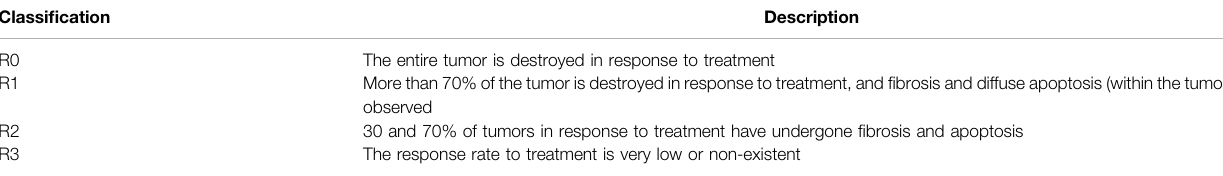
TABLE 1 | Residual tumor (R) classi fi cation.